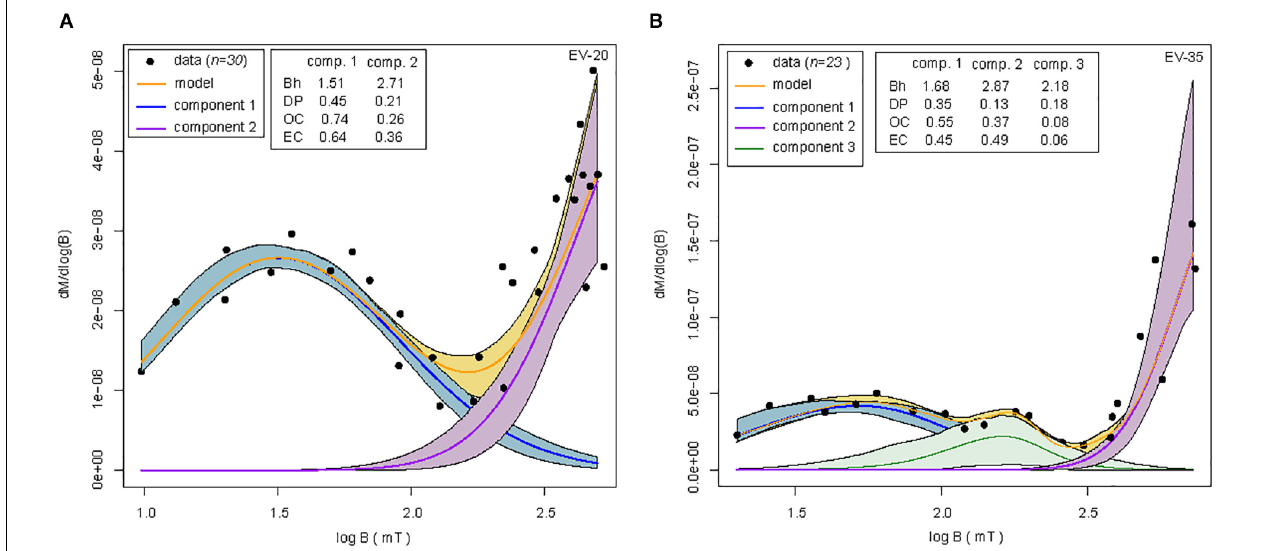
FIGURE 9 | Panels (A,B) representative model fits of coercivity spectrums from back-field measurements. Shaded areas represent 95% error envelopes of model and components. Component 1 likely corresponds to magnetite. In panel (B) , component 3 may correspond to pyrrhotite. OC, mean observed contribution; EC, estimated contribution; DP, Dispersion parameter; Bh, mean log